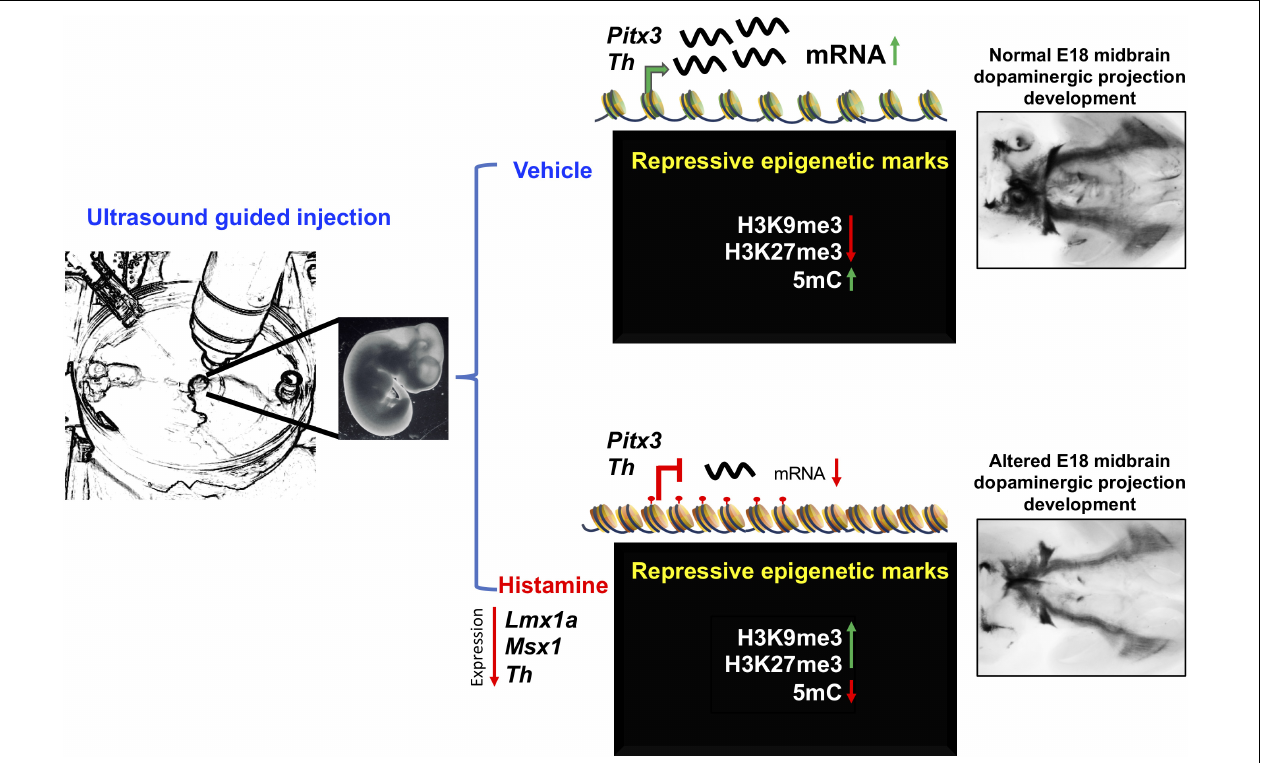
FIGURE 4 | Proposed mechanism of HA action on the regulation of late mDA differentiation genes. Intrauterine administration of HA into the MB of E12 rat embryos, decreases the expression of specification and differentiation dopaminergic genes, such as Lmx1a , Msx1 , and Th . The decrease in Th expression induced by HA was correlated with the gain of histone repressive marks, H3K27me3 and H3K9me3, together with the loss of 5mC at intergenic regulatory regions. The down-regulation of these key dopaminergic differentiation genes, particularly Th , resulted on the alteration of the midbrain dopaminergic projection development at